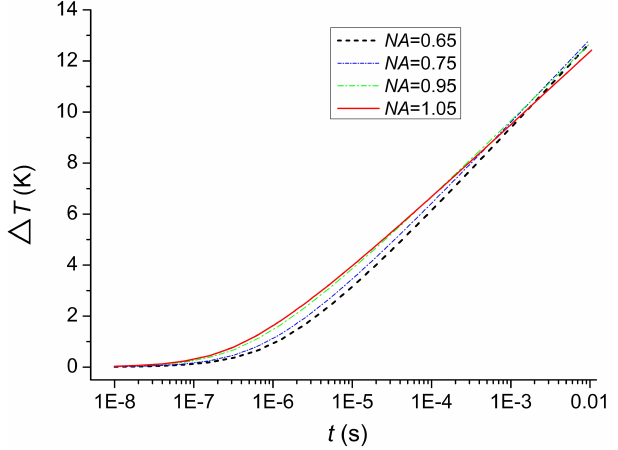
Fig. 2. Simulated temperature rise vs time for di®erent NAs of the focusing objective lens. The excitation light is 20 mW at 1700 nm.